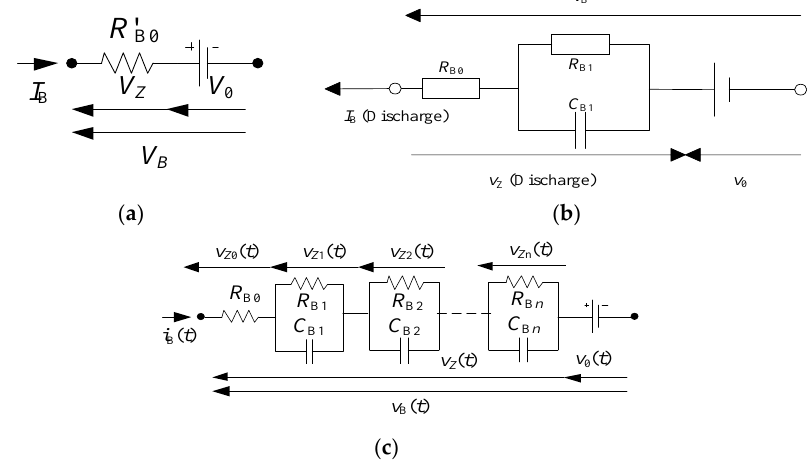
Figure 1. ( a ) Simplest conventional model. ( b ) First order model. ( c ) High order model.